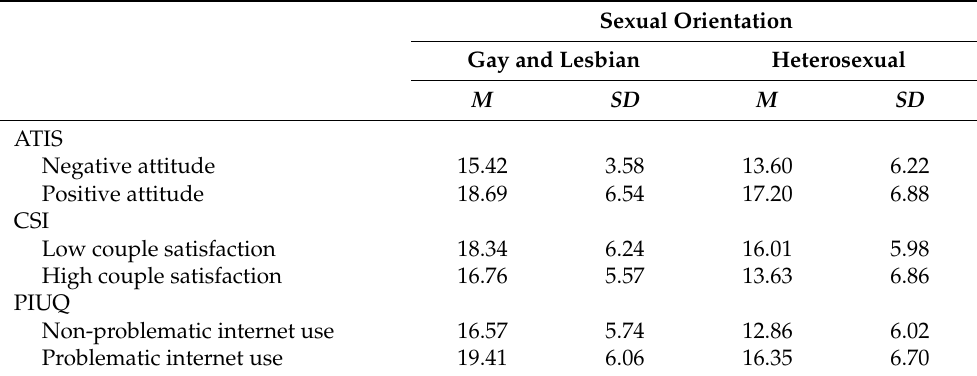
Table 4. Means and standard deviations for sexual orientation, attitude toward infidelity, couple satisfaction, and problematic internet